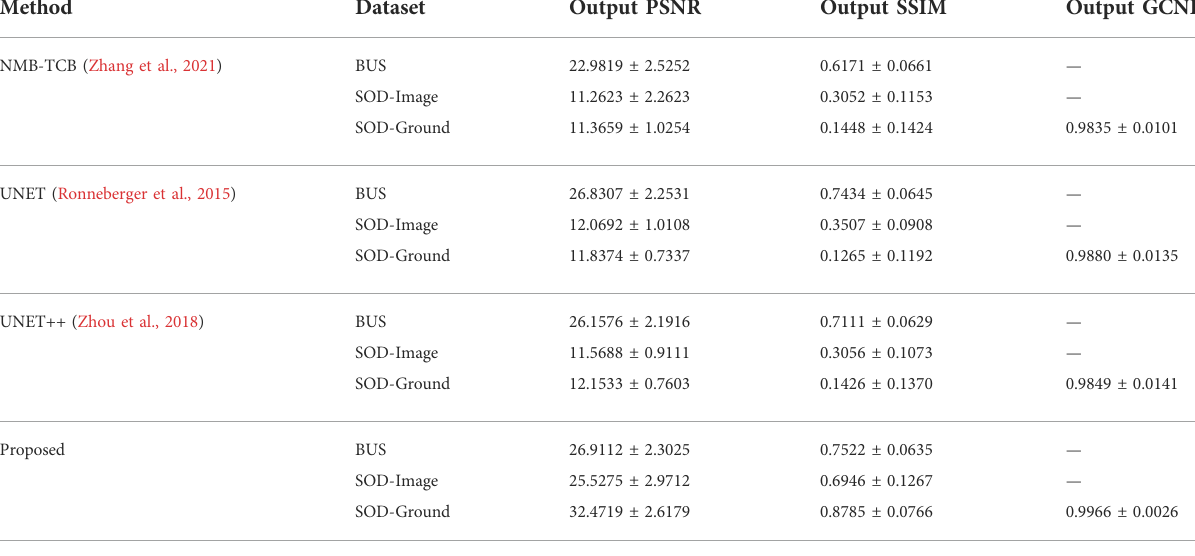
TABLE7ComaprisonofPSNR,SSIM,andGCNR results.ThemeaninputPSNR forBUSdatasetis26.0071±2.3083dB,SOD-imagedatasetis12.1587± 0.7839 dB, and SOD-Ground dataset is 12.5272 ± 0.8243 dB. The mean input SSIM for BUS dataset is 0.7098 ± 0.0761 dB, SOD-image dataset is 0.5570 ± 0.1205 dB, and SOD-Ground dataset is 0.1556 ± 0.1451 dB. The mean input GCNR for SOD-Ground dataset is 0.9936 ± 0.0039.